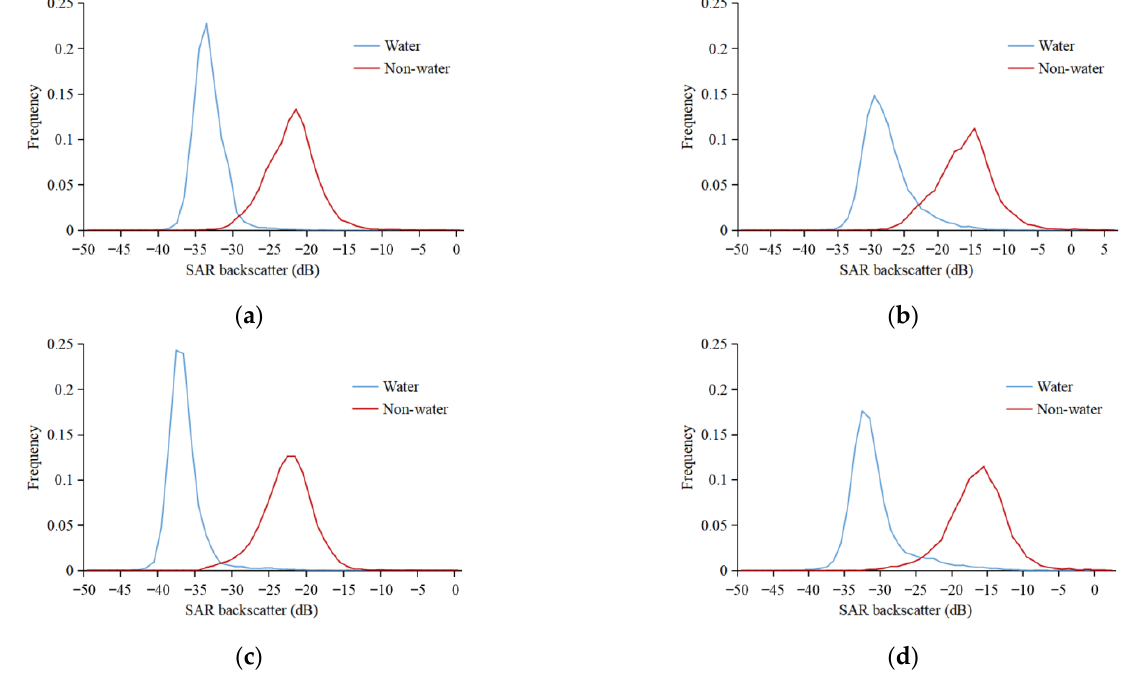
Figure 4. ( a , b ) are the water/non-water histograms of HV and HH polarization of the Boluokeng area, respectively. ( c , d ) are the water/non-water histograms of HV and HH polarization of the Pajiang area, respectively.